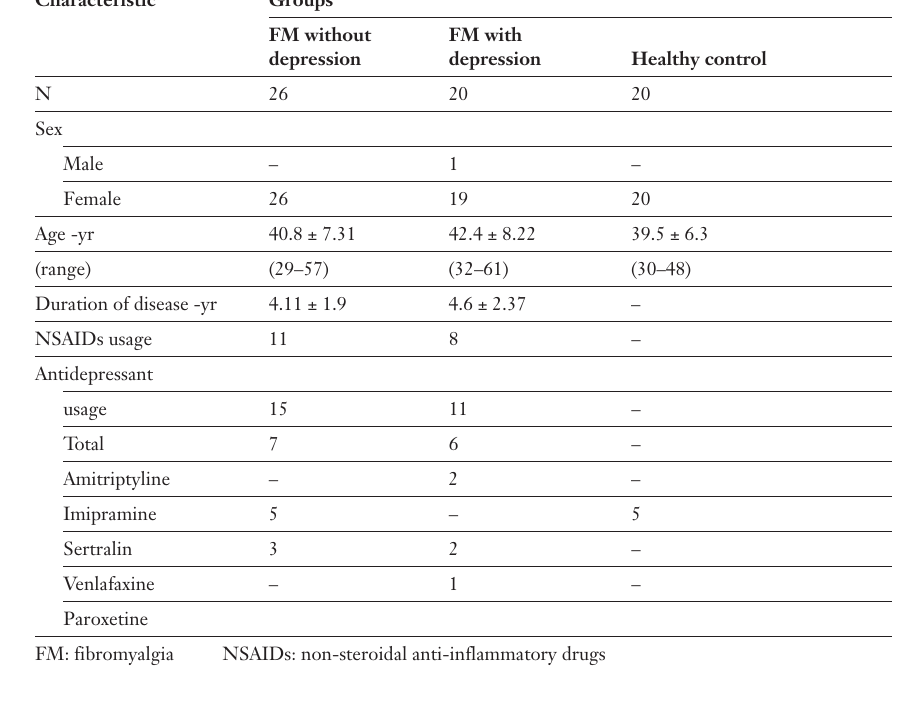
Characteristics of study groups.